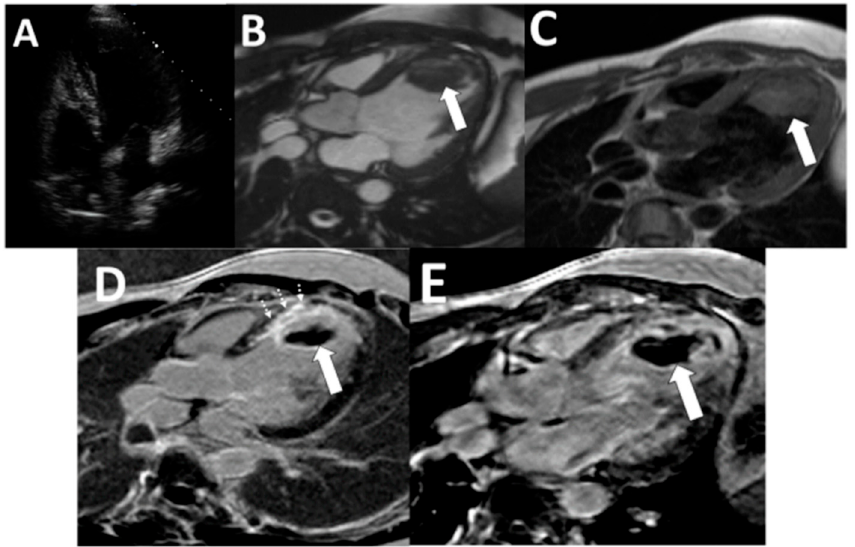
Figure 1. Examples of discordance between echocardiography and CMR. ( A ) Echocardiography was interpreted as nega- tive . ( B : arrow ) LV apical thrombus demonstrated on cine - CMR, ( C : arrow ) DB - CMR, ( D : arrow ) standard LGE - CMR with an inversion time of 250–350 ms , and ( E : arrow ) long inversion time with inversion time = 600 ms . LGE - CMR . ( D : dashed arrows ) Myocardial scar at the anteroseptal segment of the left ventricle was demonstrated on LGE - CMR . Surgical resection enabled thrombus verification based on histopathology ( not shown ). ( CMR : Cardiac magnetic resonance imag- ing, LGE - CMR : Late gadolinium enhancement sequence, DB - CMR : Dark blood sequence ).